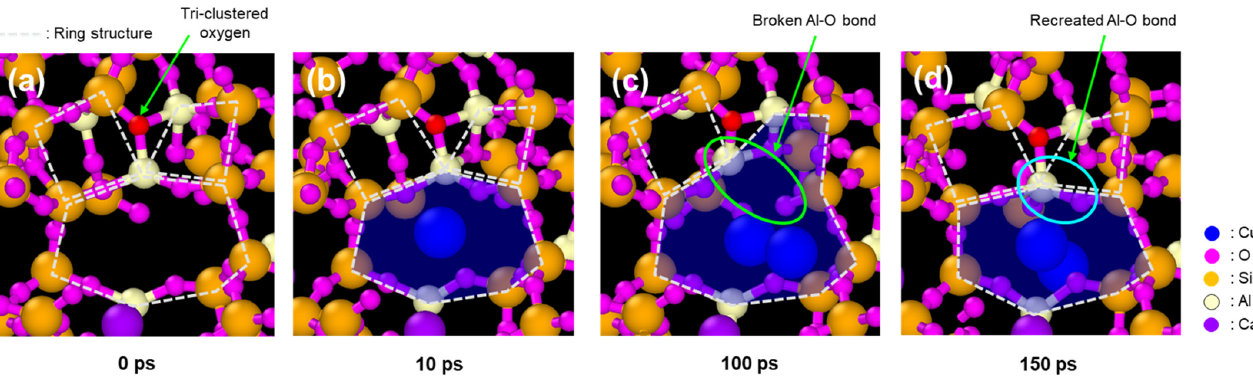
Figure 2. Incidence of Cu atoms to the local network on CAS surface: ( a ) Local silica structure with two 4-membered rings and one 7-membered ring(grey dotted line), and one tri-clustered oxygen ( b ) Incident Cu is adsorbed into the 7-membered ring (dark shaded region) ( c ) One of the bonds in the 4-membered ring is broken (green oval) due to incidence of another Cu atom ( d ) Aggregated Cu pair rotates to find its relaxed location in the 7-membered ring, then Al-O bond is recreated (cyan oval) and the 4-membered ring is restored.